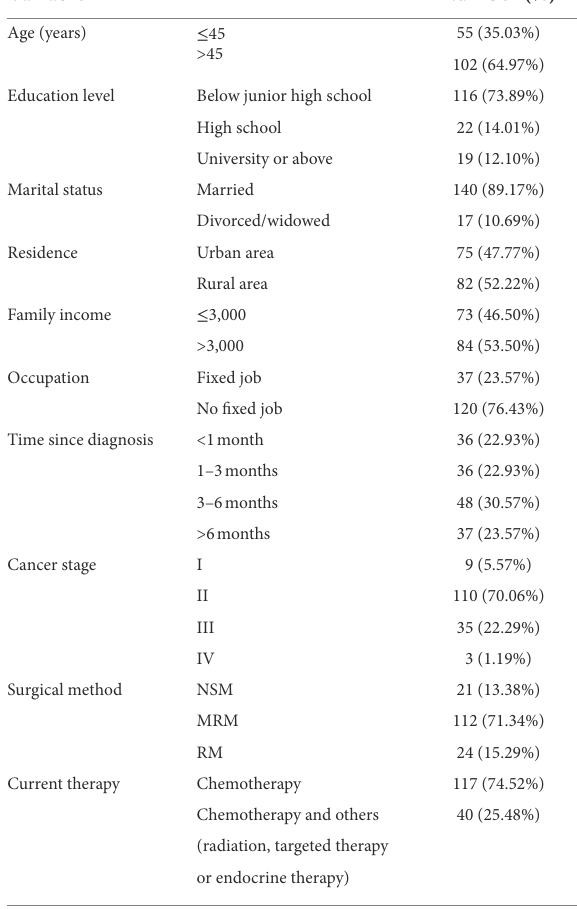
TABLE 1 Demographic and clinical characteristics ( n =